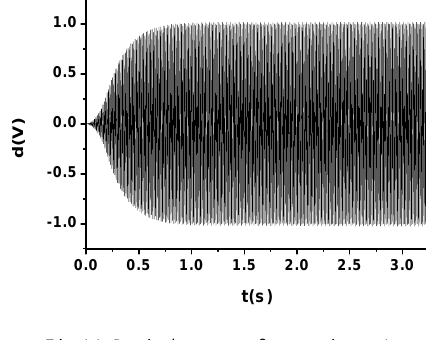
Fig. 14. Desired response for experiment 4.